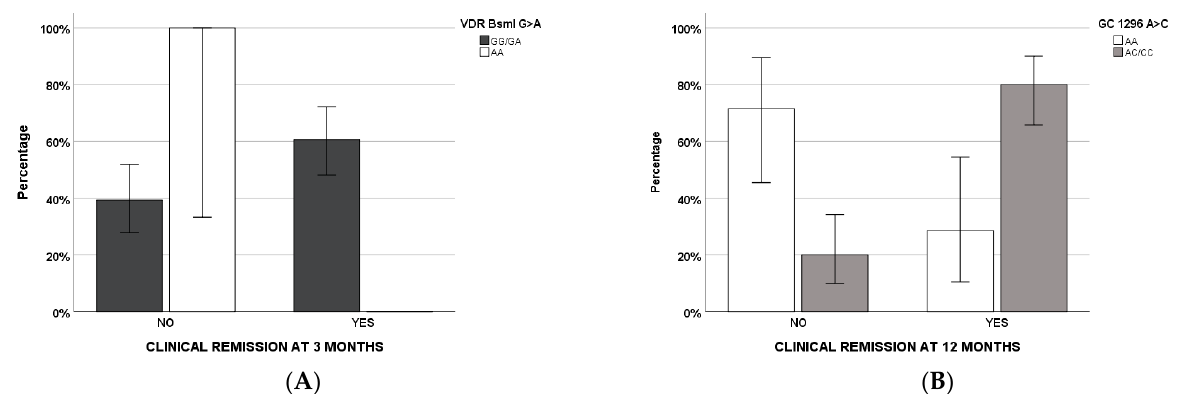
Figure 3. Clinical remissions according to genetic variants ( VDR BsmI G>A in ( A ), GC 1296 A>C in ( B )) that remained in the final regression models.